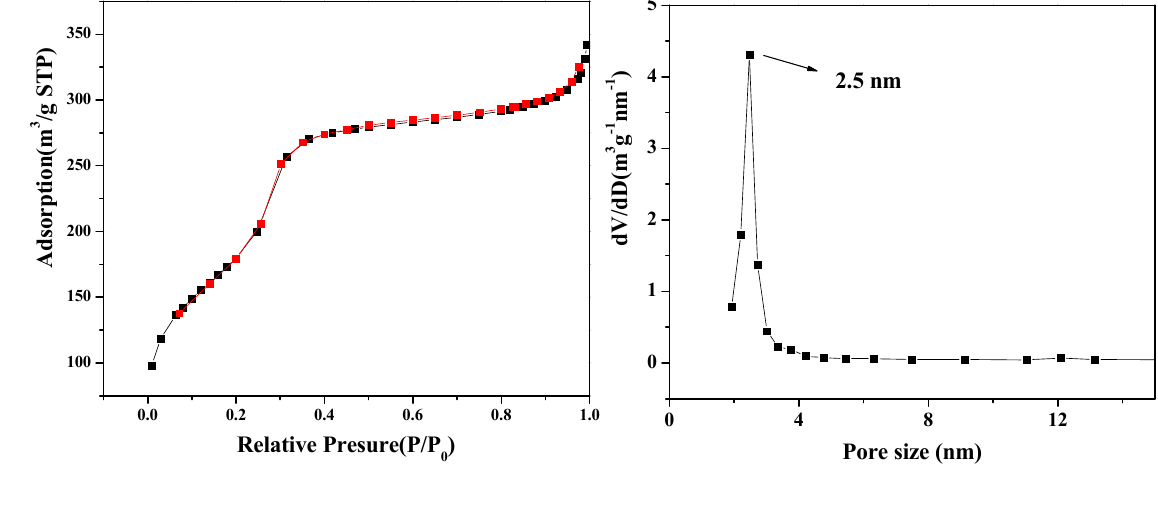
Figure 4. The nitrogen adsorption-desorption isotherms and pore size distribution of m-SiO